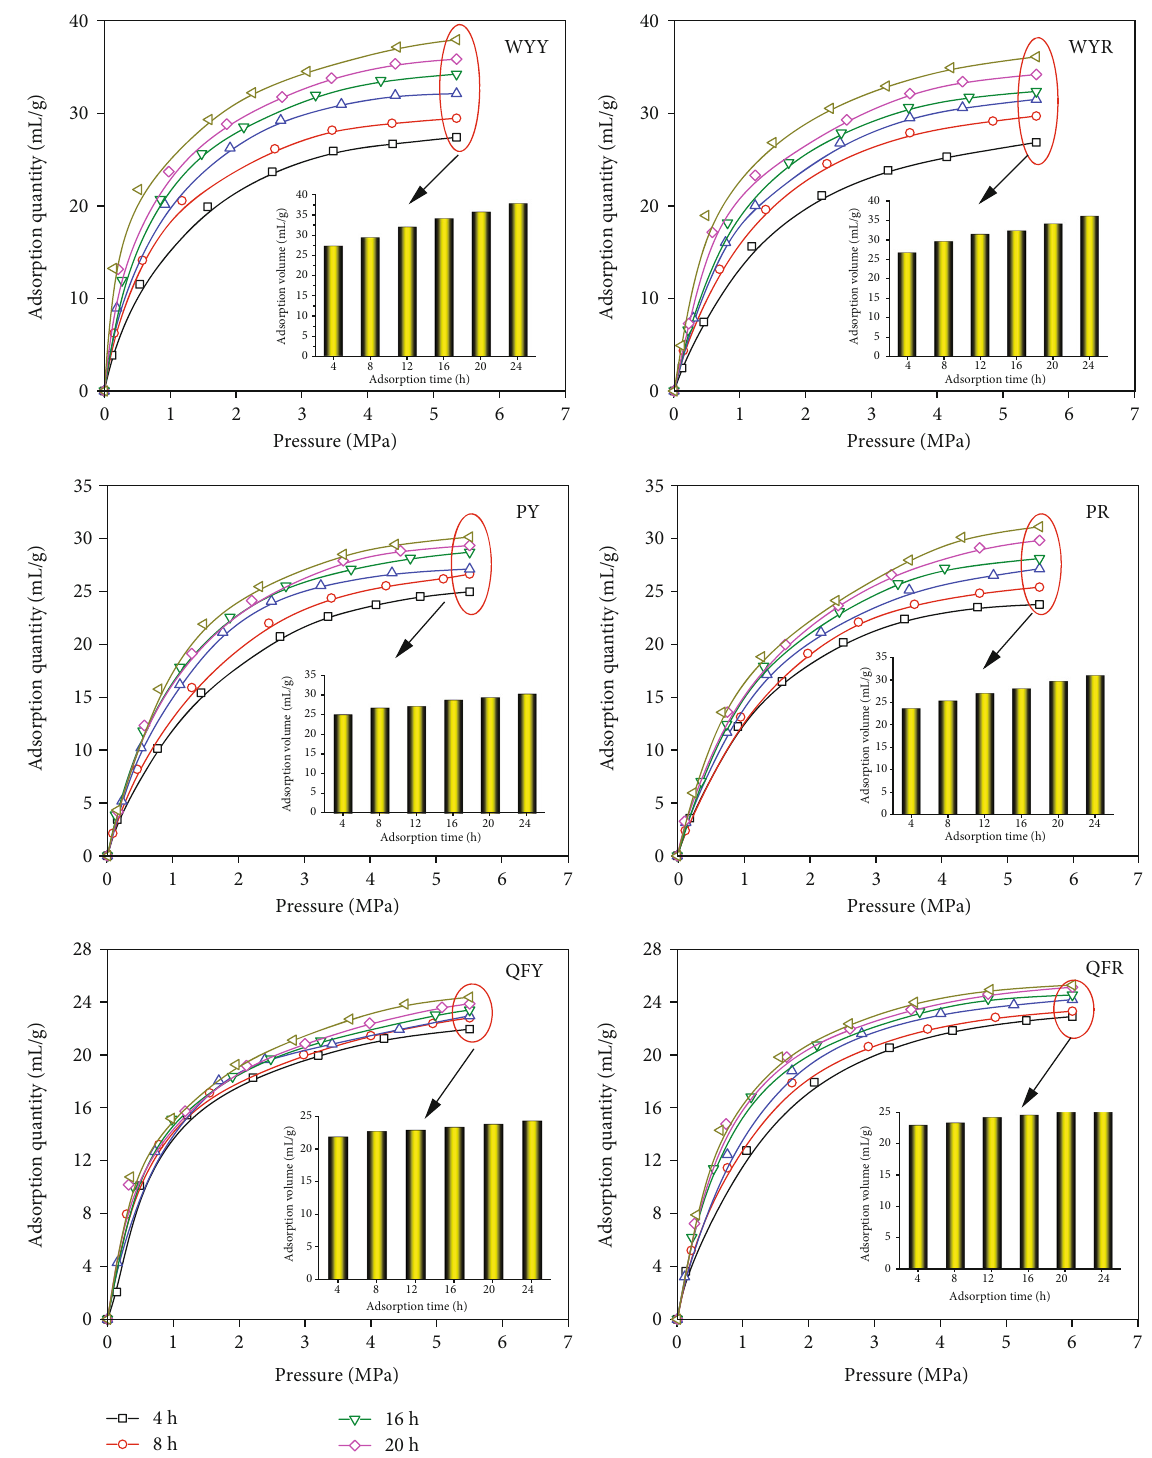
Figure 7: Methane adsorption isotherm at di ff erent adsorption times and the fi tting Langmuir